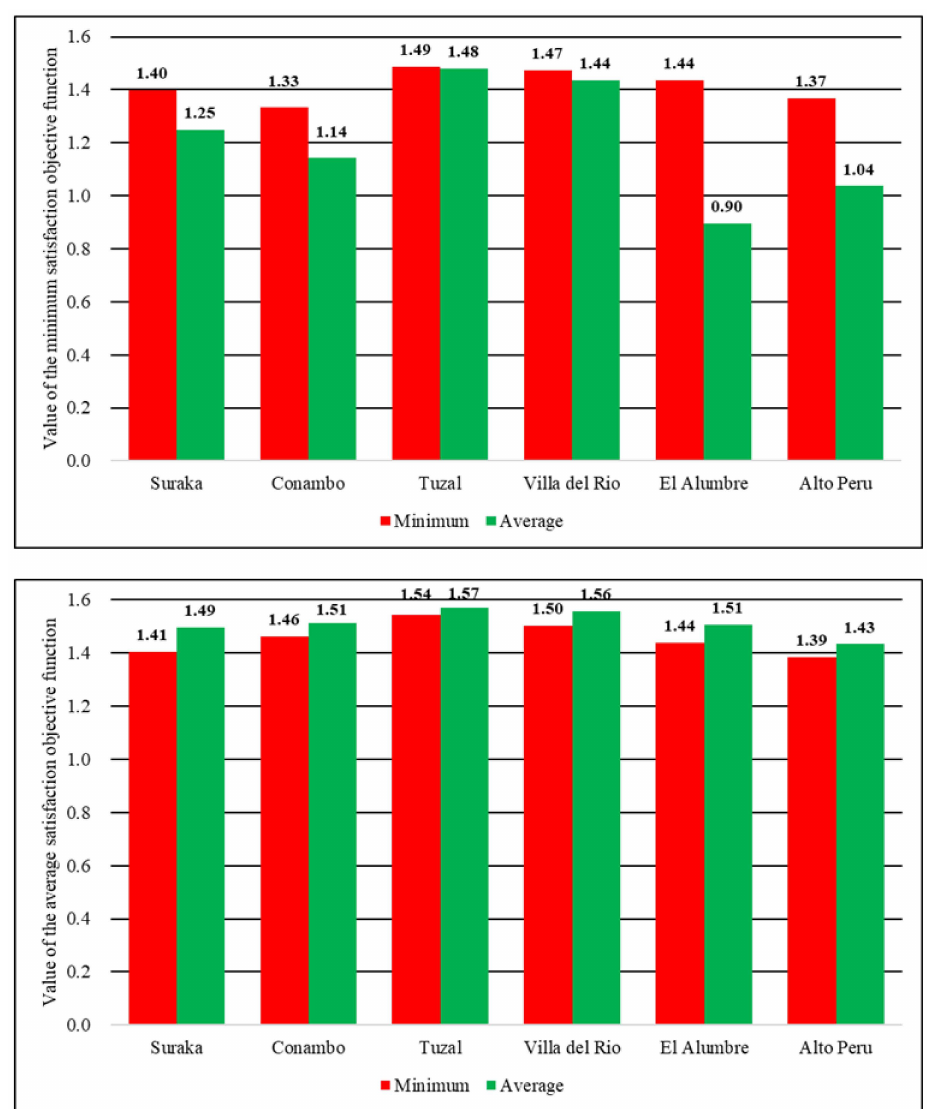
Figure 6. Comparison of the objective function values between